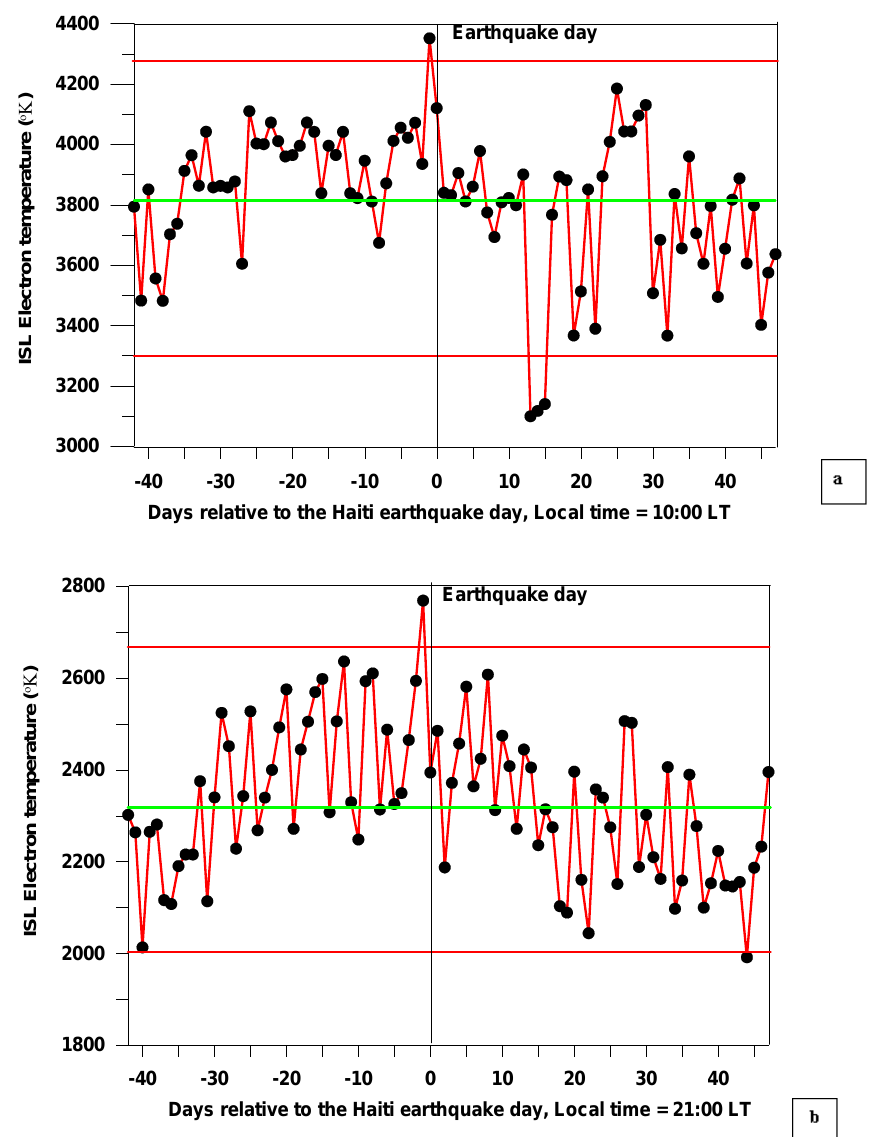
Fig. 3. Results of DEMETER analysis for Haiti earthquake from December 2009 to February 2010. Earthquake day is represented as vertical dotted line. The red horizontal lines indicate the upper and lower bounds. The green horizontal line indicates the mean value (M). The x-axis represents the day relative to the earthquake day. The y-axis represents (a) electron temperature derived by the measurements of the ISL experiment during daytime (b) electron temperature derived by the measurements of the ISL experiment during